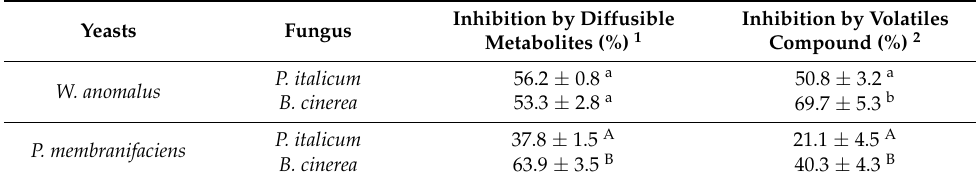
Table 1. In Vitro antagonistic activity of the killer yeasts against the fungi, expressed as percentages of the fungal colony